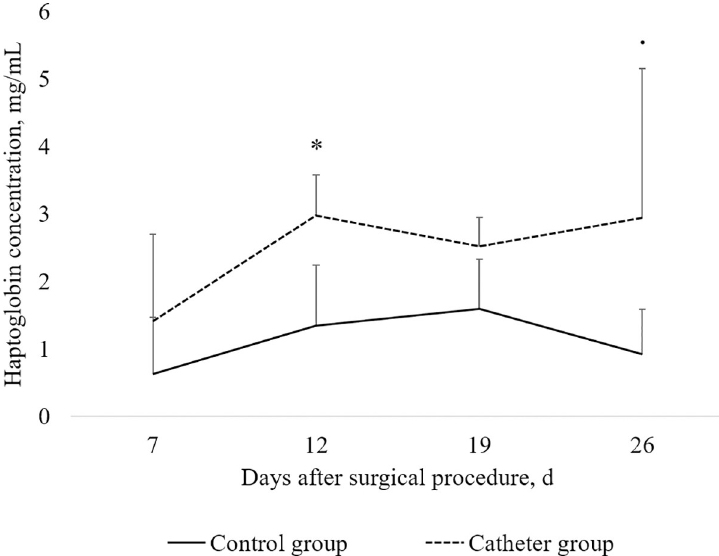
Fig 6. Effect of catheter insertion at 21 days of age (d0) on haptoglobin concentration in plasma of piglets measured at d7, d12, d19, and d26 after the surgical procedure. Values shown are means ± SDs. Statistical analysis was performed by ANOVA for each day using the experimental group as a fixed effect and the sow as random effect (MIXED procedure, SAS 9.4, SAS Institute Inc. Cary, NC, USA). Values that significantly differ ( � P < 0.05) or tend to differ (. P < 0.10) between the Control group (n = 7) and the Catheter group ( n = 7, 4, 3 and 3 for d7, d12, d19 and d26 respectively) are indicated on the